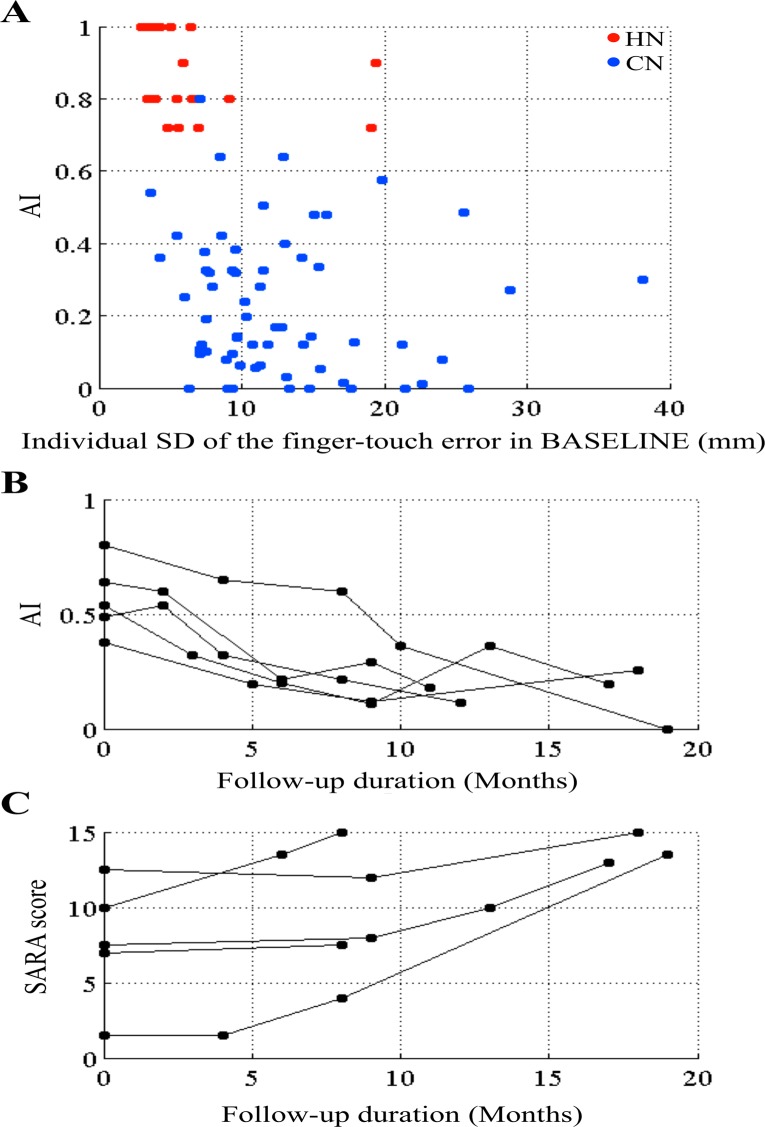
Relationship between AI and incoordination.(A) AI and the magnitude of dysmetria represented by the SD of the finger-touch error in BASELINE. Data were obtained from 62 CN patients (blue dots) and HN subjects (red dots). Each point represents data obtained from one subject. (B) and (C) Tracking AI (B) and SARA (C) data of each MSA patient (CN56, CN57, CN59, CN60, and CN61; n = 5).